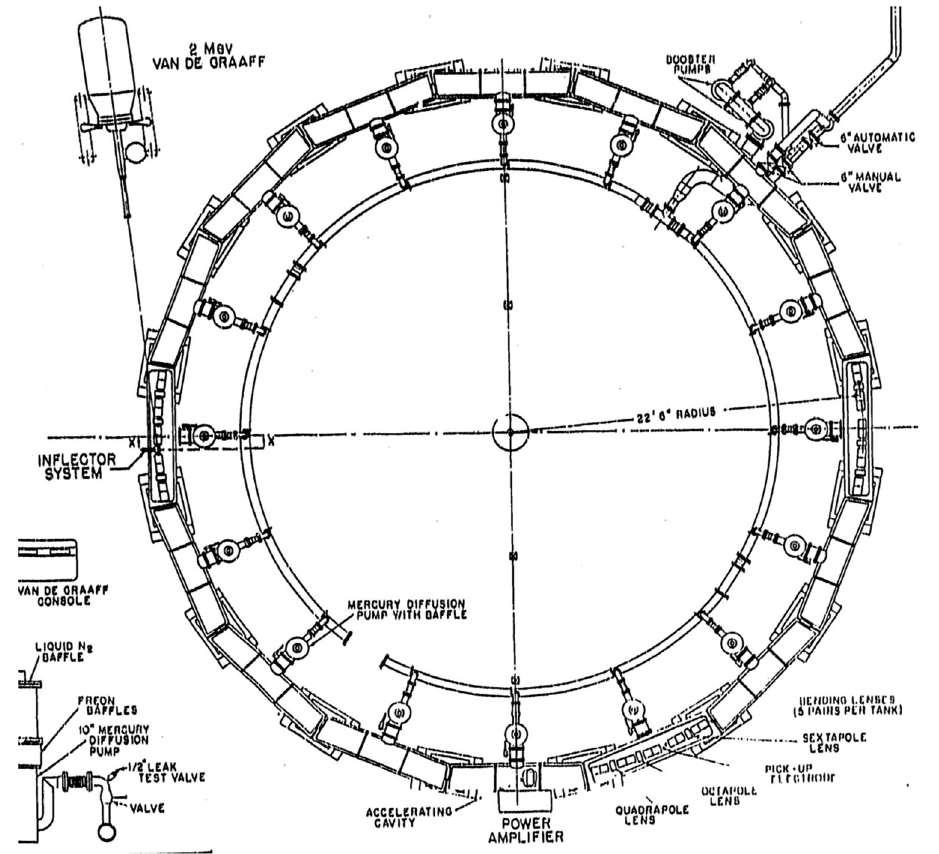
FIG. 12. Electric “ lenses ” were contained, 10 to a tank, within the 16 vacuum “ tanks ” making up the full AGS analog ring. Each tank therefore contained 2 1 lattice cells, as well as miscellaneous, special purpose quadrupoles, chromaticity-correcting sextupoles and 2 octupoles. This was published with permission of Brookhaven National